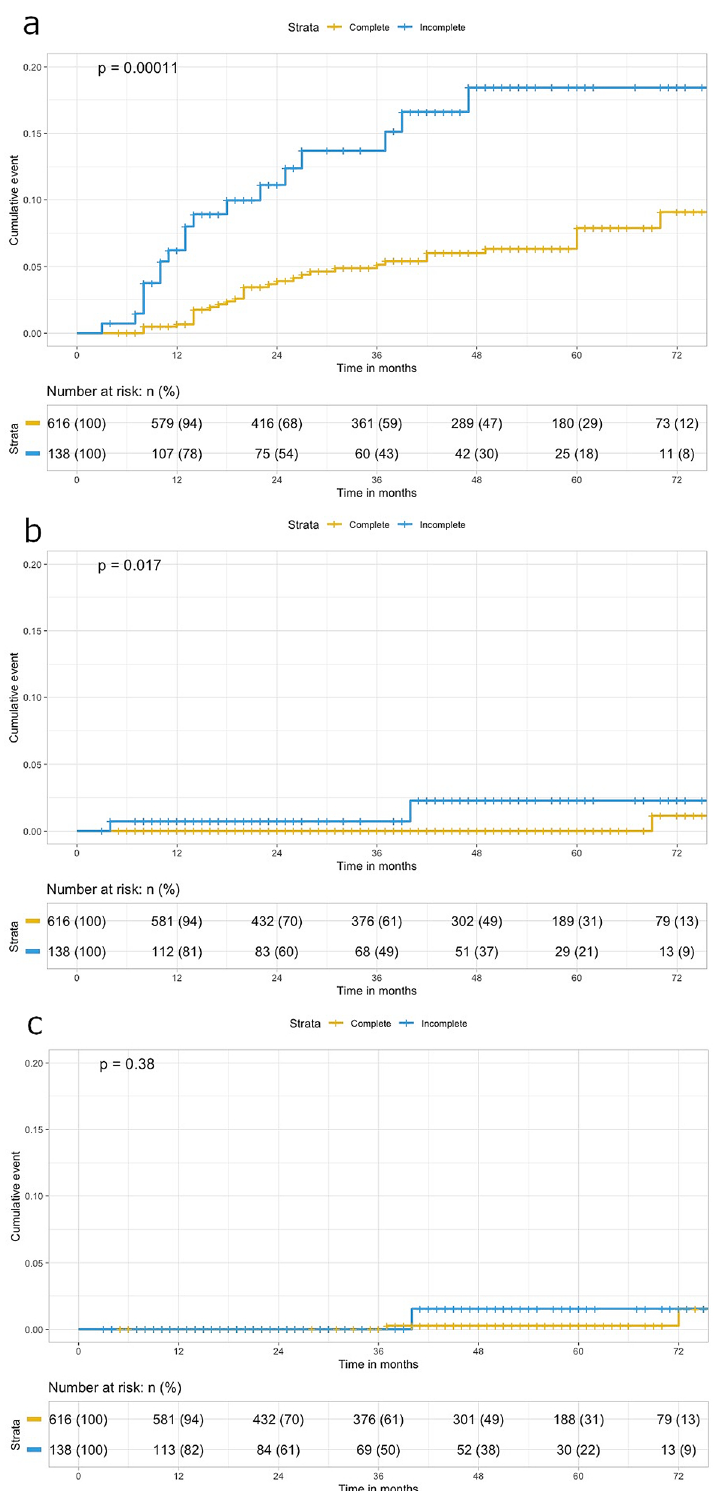
Figure 1. Comparison of cumulative risk after index surgery for detection of advanced adenoma ( a ), carcinoma ( b ), additional operation ( c ) in all enrolled